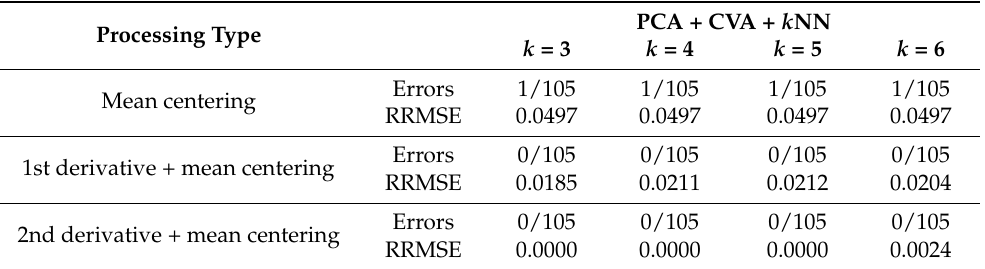
Table 4. Study No. 1 with combined NIR + MIR spectral data. Prediction-set classification errors (105 samples).